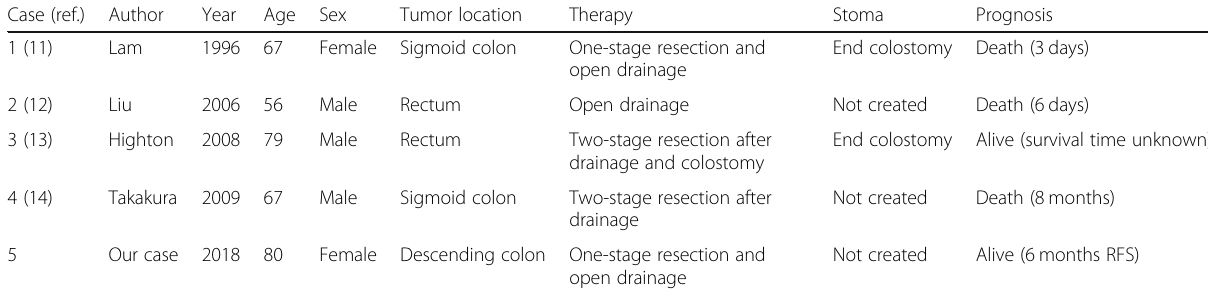
Table 2 Cases of necrotizing fasciitis associated with colorectal cancer Case (ref.)